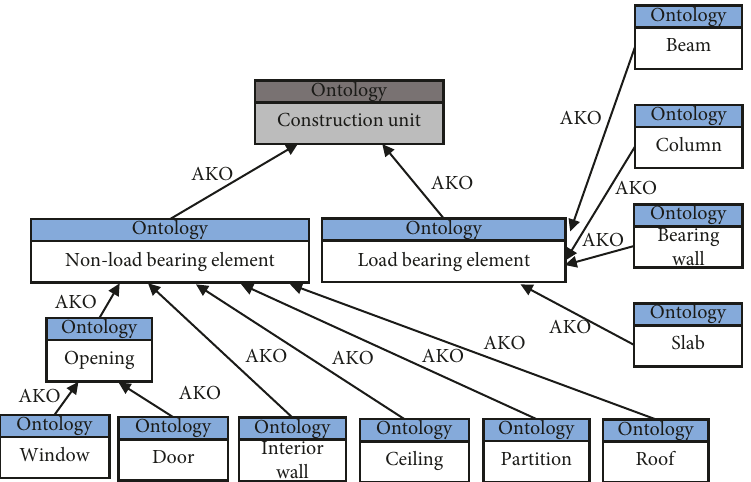
Figure 4: Construction units (CUs).